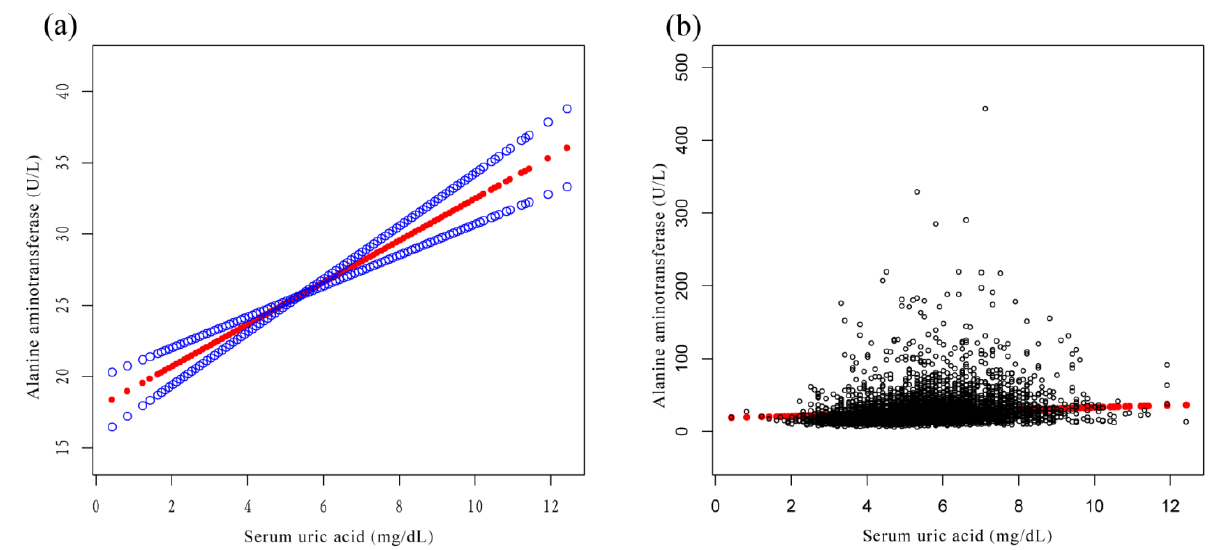
Figure 2. Relationship between serum uric acid and liver enzymes. ( a ) Relationship between serum uric acid and alanine aminotransferase (R 2 = 0.150). The red line represents the fitted curve, and the blue line represents the 95% confidence interval. ( b ) Each black point represents a sample, and the red line represents the fitted curve.